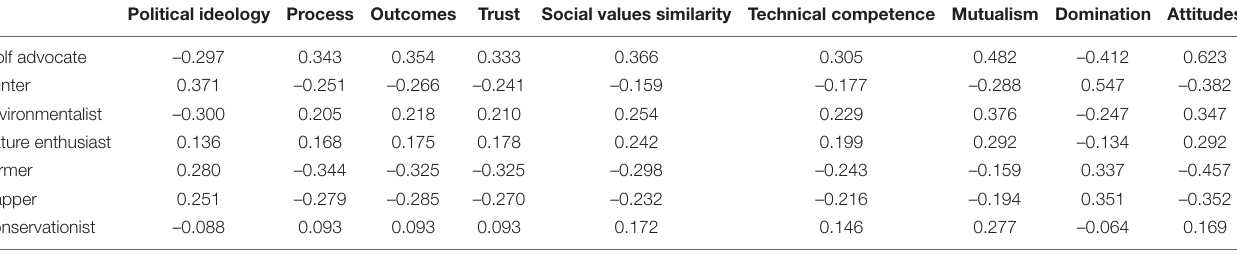
TABLE 3 | Bivariate correlations of identities with political ideology and trust in the state wildlife management agency for wolf stakeholders in Minnesota, United States. Political ideology Process Outcomes Trust Social values similarity Technical competence Mutualism Domination Attitudes